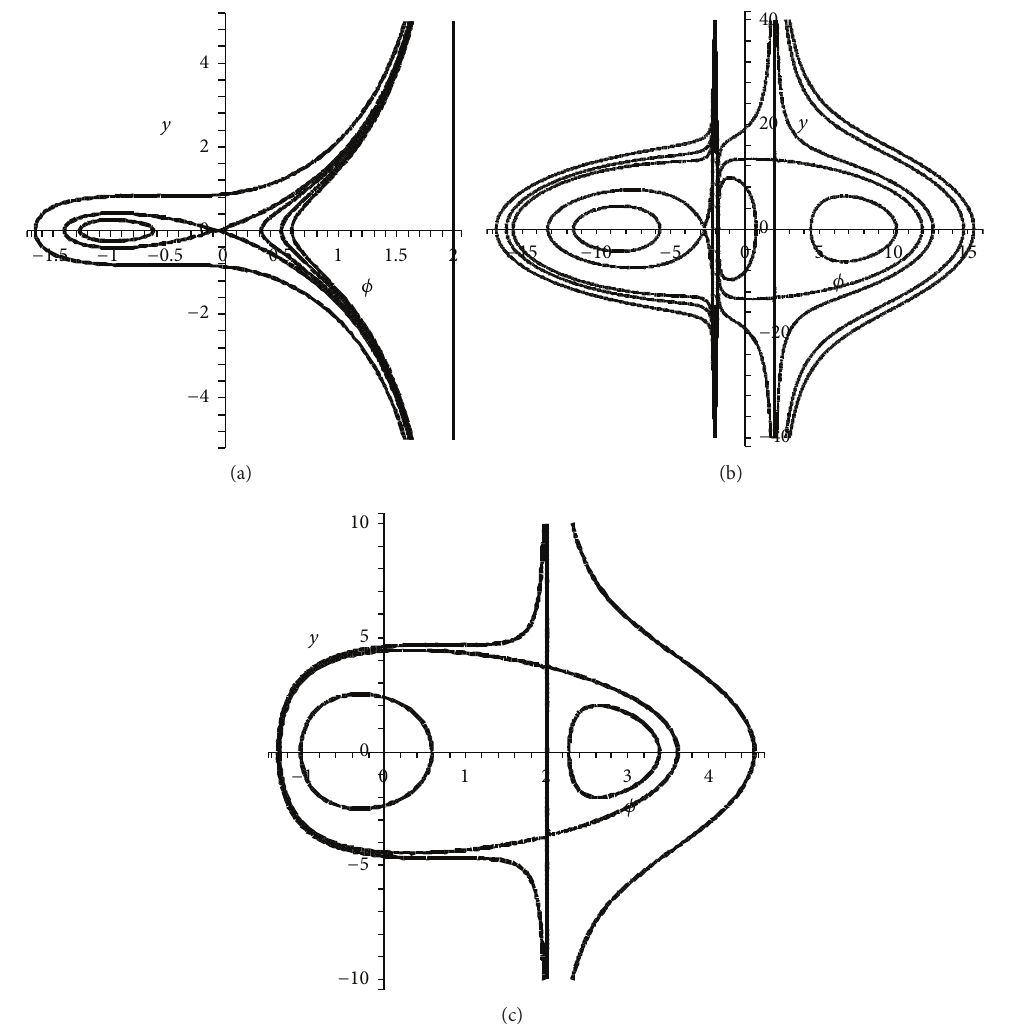
Figure 2: Phase portraits of (10) for 𝜙 ̸= −𝑐 , taking minus sign. (a) The case for 𝐹(𝑐) > 0 , −(1/2)𝑐 2 ≤ 𝑔 < (1/4)𝑐 2 , 𝐹(𝜙 + ) < 0 . (b) The case for 𝐹(𝑐) < 0 , 𝑔 < −(1/2)𝑐 2 , 𝐹(𝜙